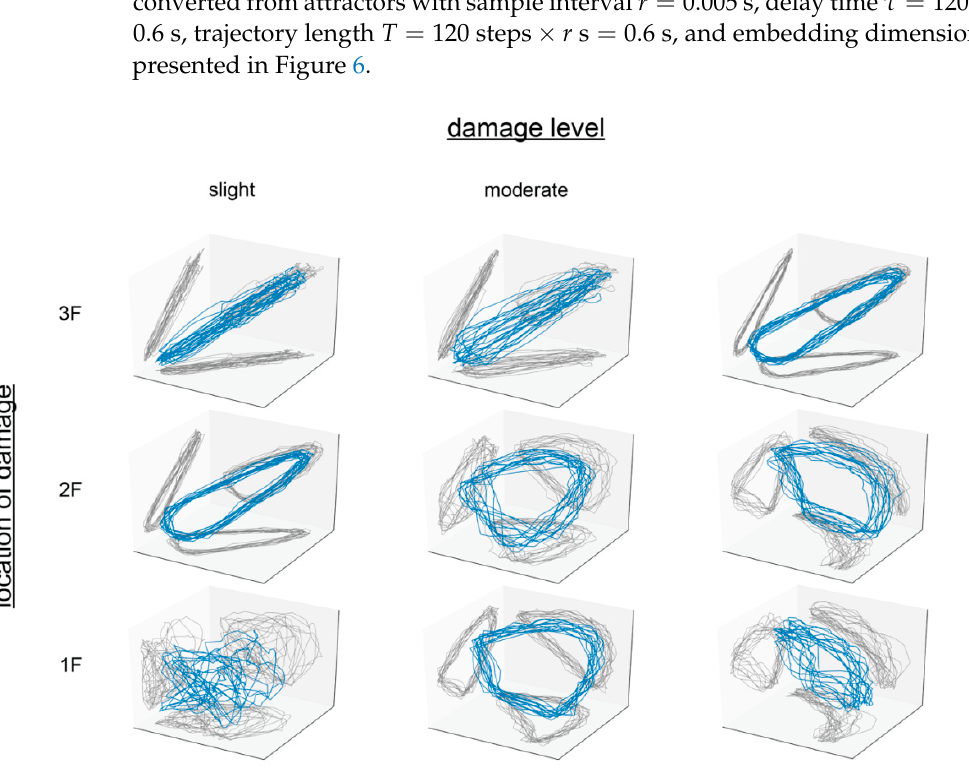
Figure 5. Examples of the attractor in a three-dimensional reconstruction space.